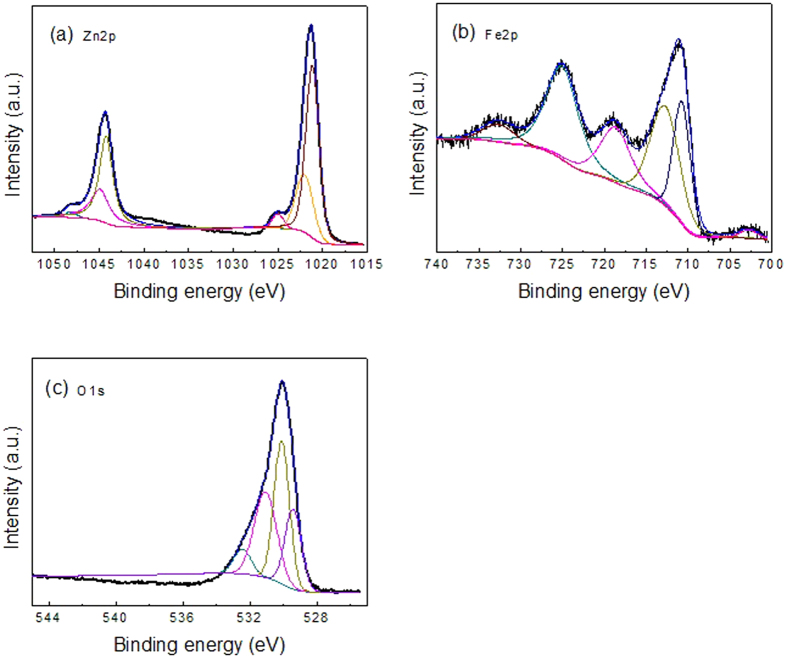
XPS analysis for the ZnO/ZnFe2O4 nanoparticles: (a) Zn 2p, (b) Fe 2p and (c) O 1s.